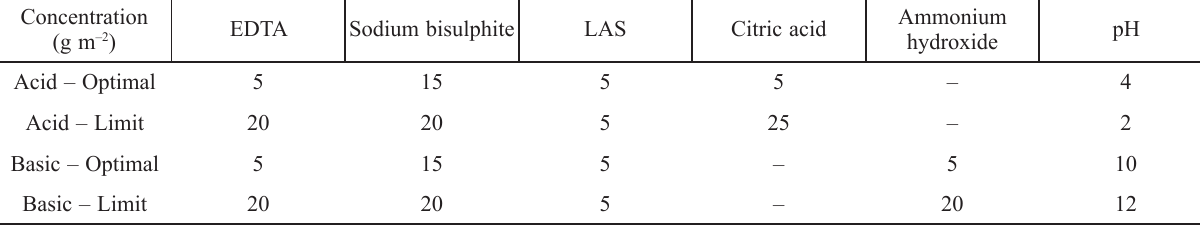
Fig. 4 Micrograph (a) and cross-sectional micrograph (b) of the fouled membrane (1000X)